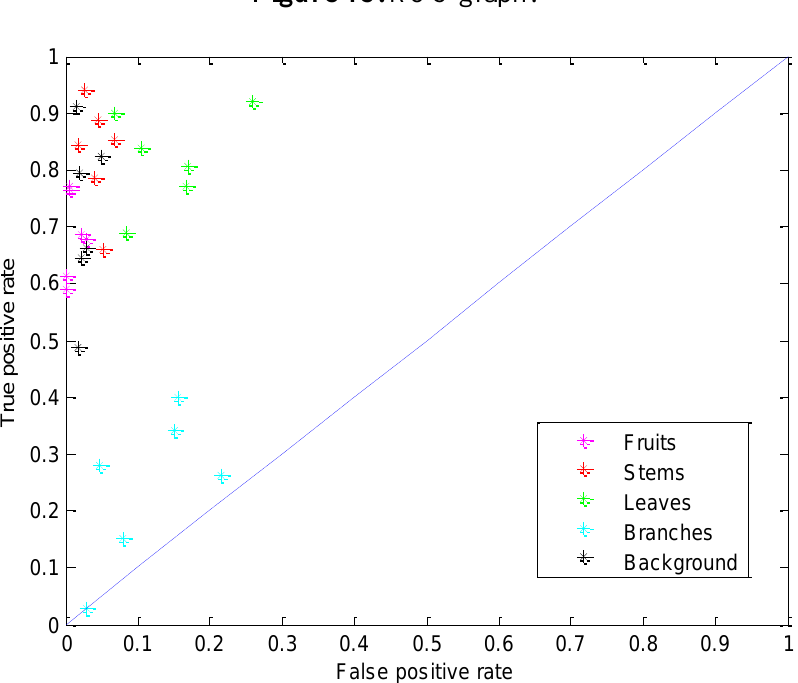
Figure 15. ROC graph.